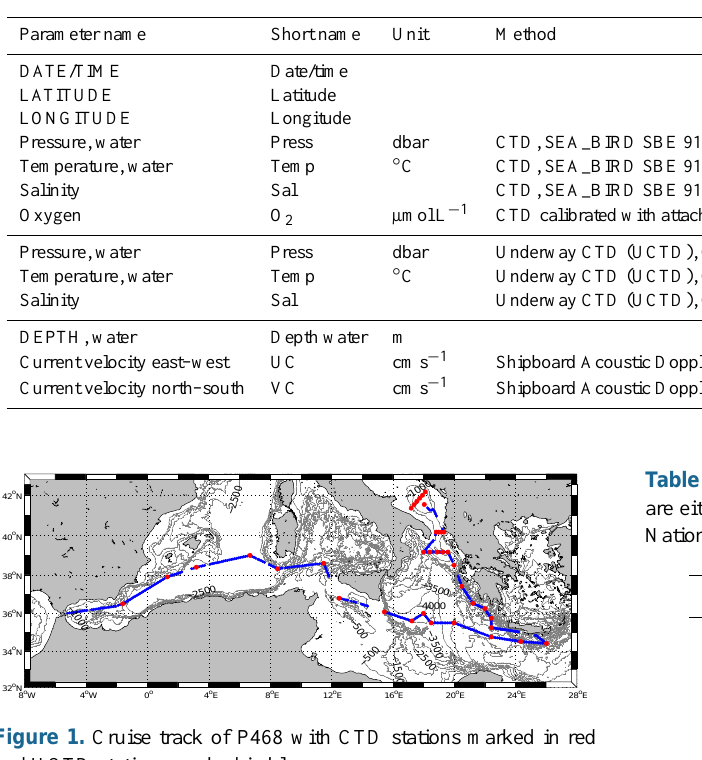
Table 1. List of parameters from Poseidon cruise P468 as seen in the PANGAEA database. PI (Principal Investigator): Dagmar Hainbucher.